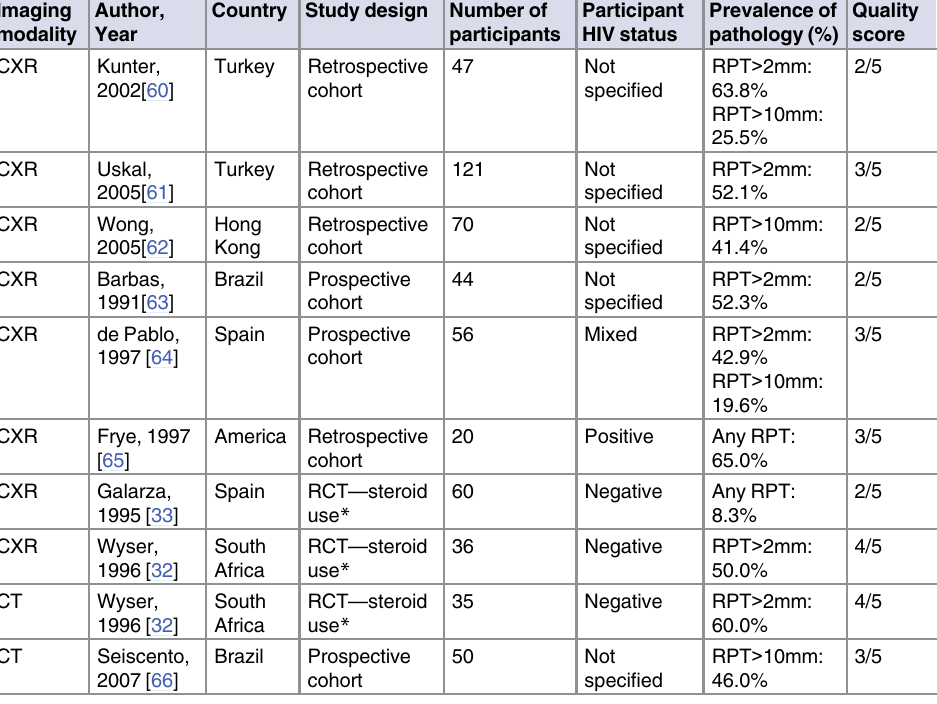
Table 5. Studies of residual pleural thickening (RPT) on completion of treatment for TB pleural effusion. Imaging Author, modality